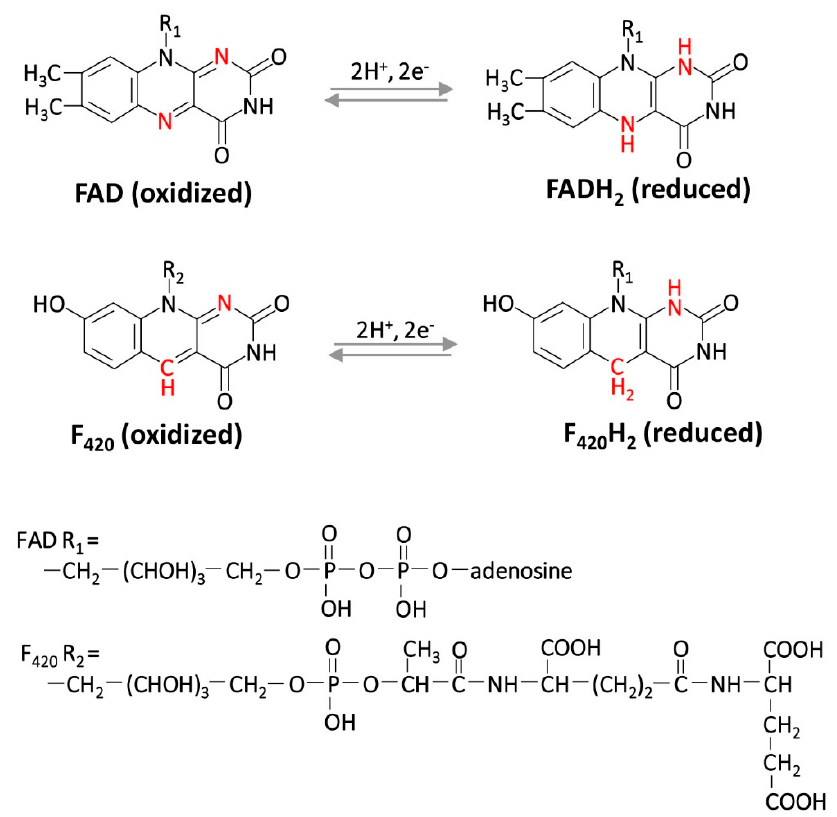
Figure 4. Comparison of coenzyme F 420 and FAD oxidized and reduced forms.